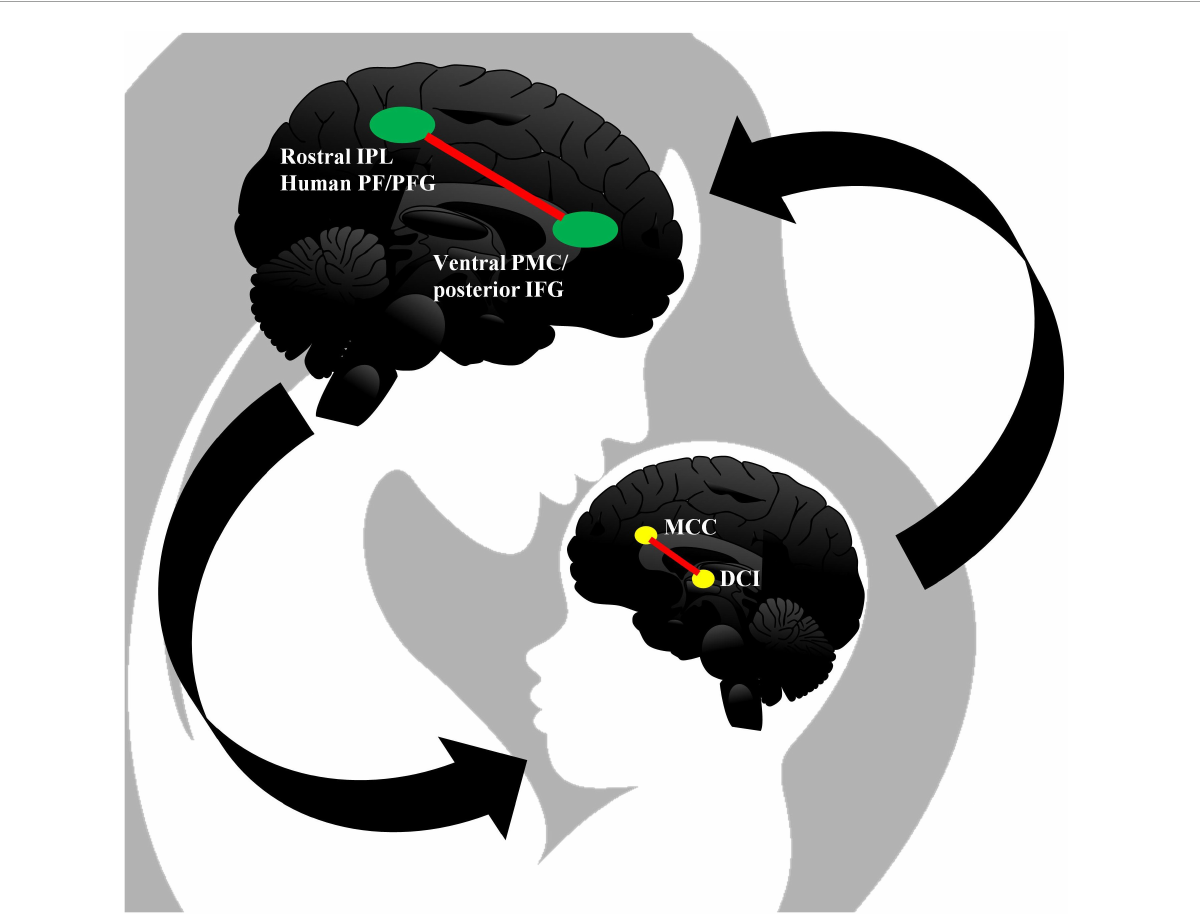
FIGURE1 The neural bases of vitality forms (and human mirror neuron system, MNS) in a mother–infant communicative dyad. In the brain of the mother, the human MNS is composed of two parts: frontal MNS and parietal MNS. Generally, the anterior region with mirror neuron properties is located in the sub-frontal cortex, including the posterior frontal gyrus (IFG) and the adjacent ventral premotor cortex (PMC); the posterior region with mirror neuron properties is located in the rostral section of the inferior parietal lobe (IPL) and can be regarded as the human homolog of region PF/PFG in the macaque (cf. Pandya and Seltzer, 1982; Iacoboni and Mazziotta, 2007; Iacoboni, 2009; Bermúdez, 2020, p. 372). In the brain of the young baby, the picture presents a mirroring mechanism tuple (based on current trustworthy neuroimaging findings) of MCC and DCI, which can deal with observation and execution of vitality forms of action. Vitality forms occupy a new dimension apart from the what- and why-dimension of action, and ongoing actions per se convey enough in revealing the signatures of social perception. In a series of fMRI